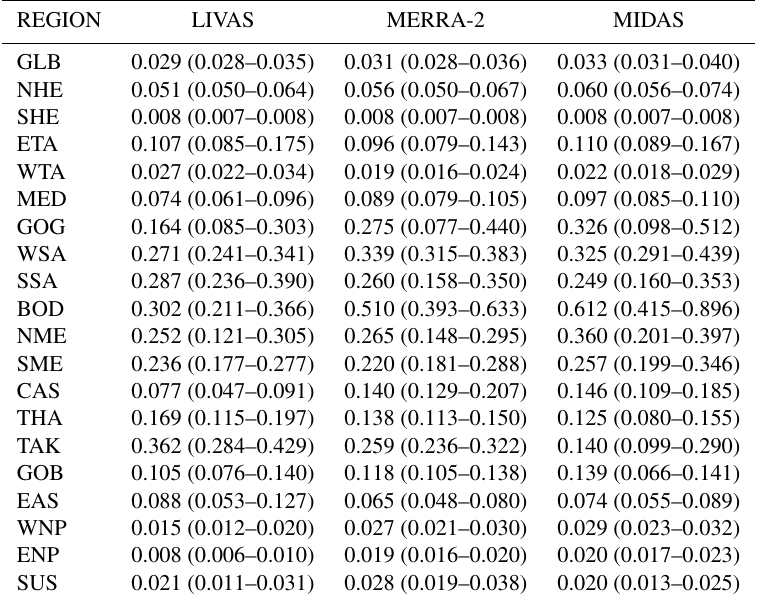
Table 1. Planetary (GLB), hemispherical (NHE and SHE), and regional DOD averages representative for the period 2007–2015, based on colocated LIVAS, MERRA-2, and MIDAS 1 ◦ × 1 ◦ data. Within the parentheses, the minimum and maximum annual values are given. The regional averages have been calculated following the upper branch (first temporal averaging and then spatial averaging) in Fig. 5 of Levy et al. (2009). The full names of the acronyms for each subregion are given in the caption of Fig.